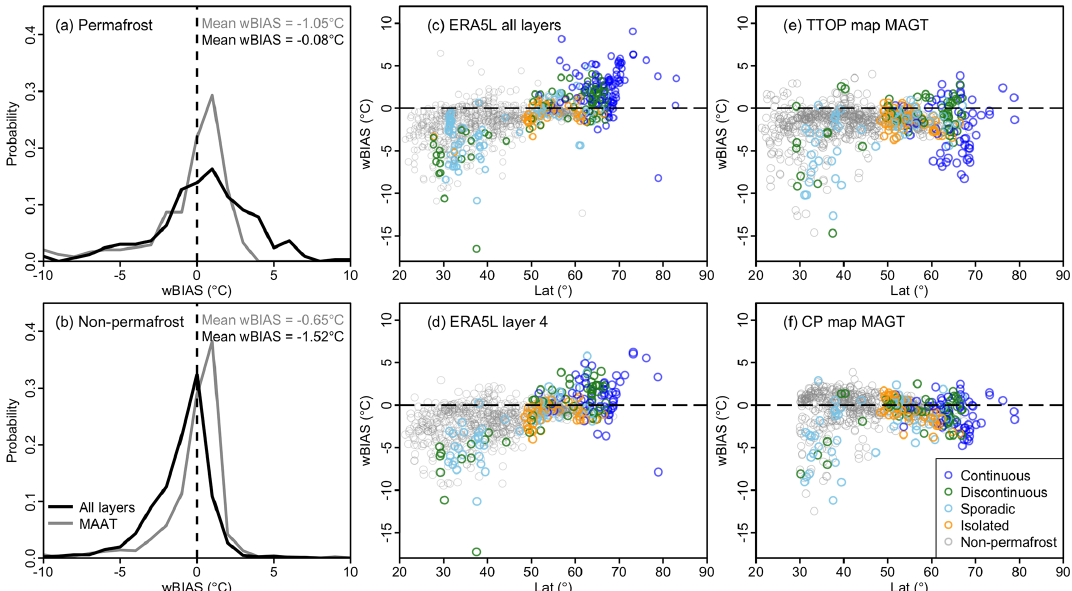
Figure 3. (a, b) The wBIAS (observations − ERA5L) density of ERA5L mean annual air temperature (MAAT) and mean annual ground temperature (MAGT) in permafrost (a) and non-permafrost (b) regions as a whole. (c–f) wBIAS of ERA5L overall MAGT (c) , the last layer (d) , TTOP map MAGT (e) , and CP map MAGT (f) grouped by permafrost zone.